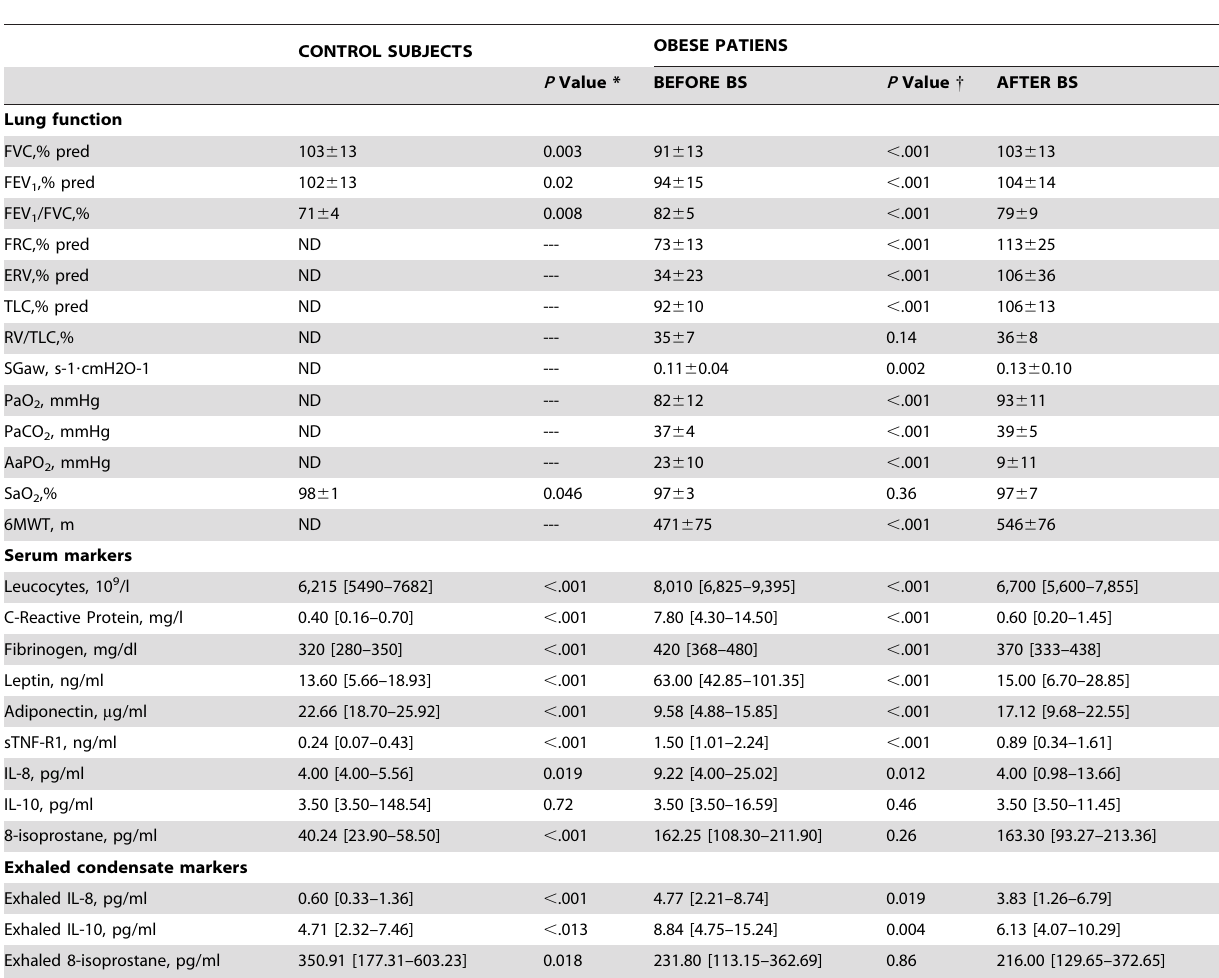
Table 2. Lung function and inflammatory markers in control and obese participants, before and after bariatric surgery (mean 6 SD or median [interquartile